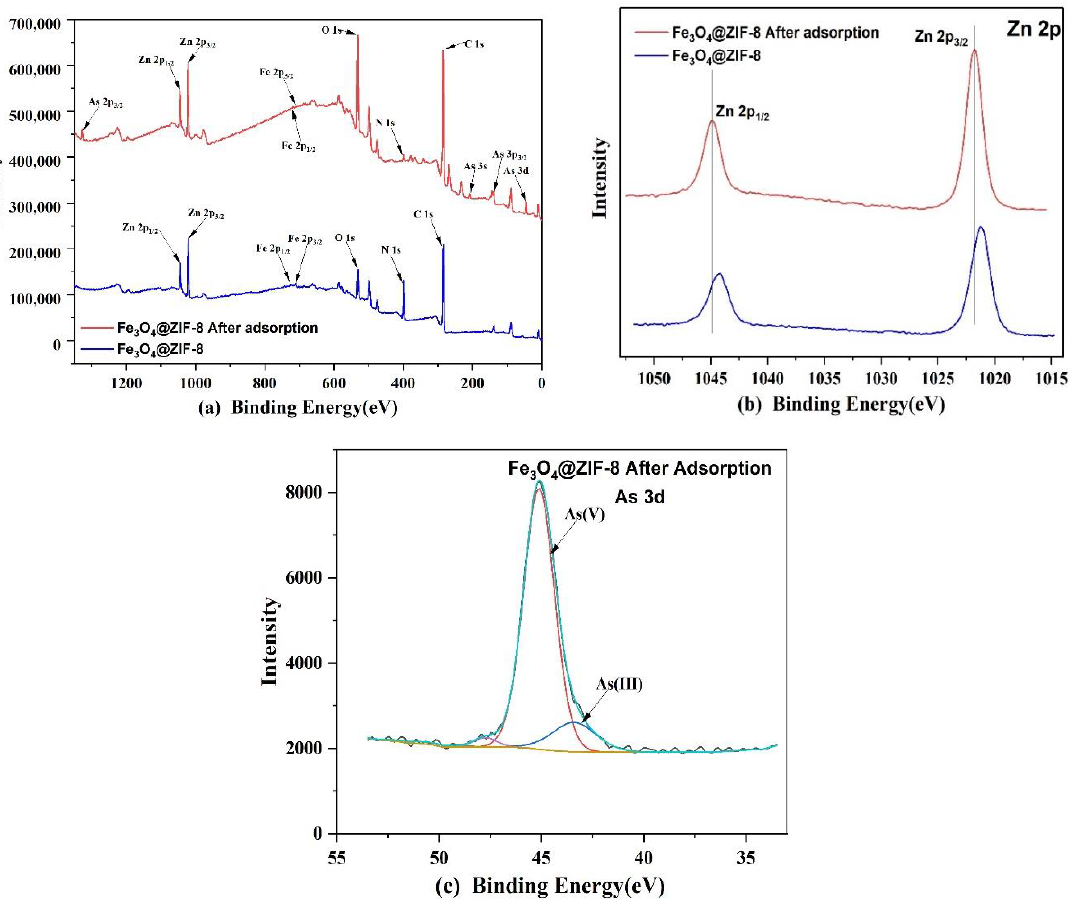
Figure 11. XPS spectra of Fe 3 O 4 @ZIF-8: ( a ) Wide scan; ( b ) Zn 2p core level. ( c ) As 3d core level after adsorption.